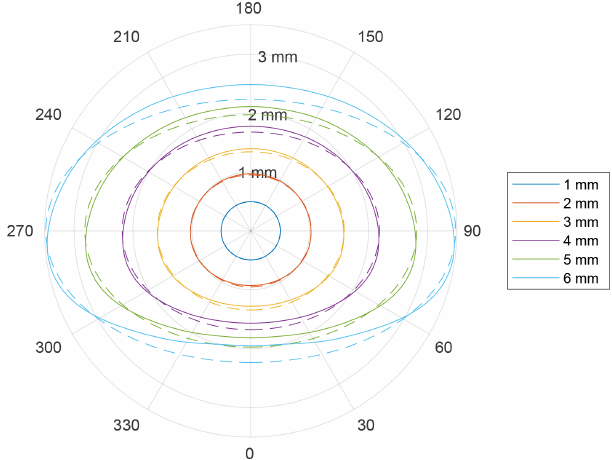
Figure 1. Raindrop cross sections for different volume-equivalent diameters. Full lines represent the equilibrium/Chebyshev drops, and the dashed lines the aspect-ratio-equivalent